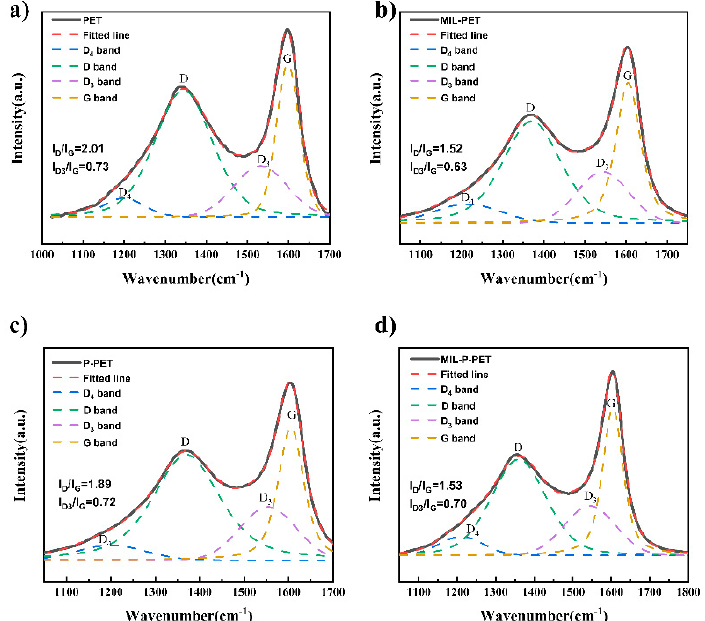
Figure 8. Raman spectra and its fitted lines of the char residue of ( a ) PET, ( b ) MIL − PET, ( c ) P − PET, ( d ) MIL − P − PET.